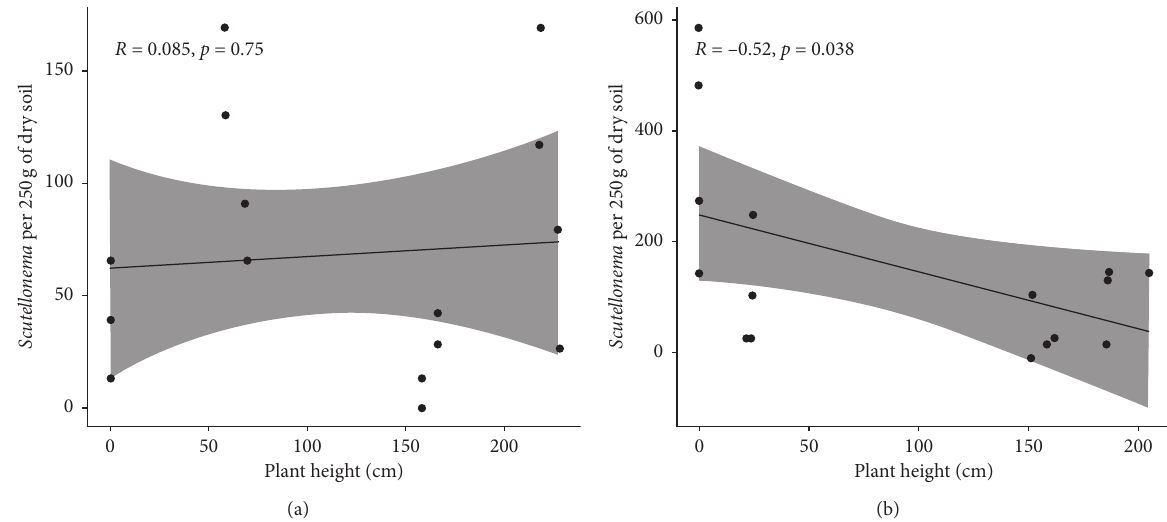
Figure 2: Correlation between plant height and Scutellonema abundance during trial one in 2018 (a) and trial two in 2019 (b) in MPWN treatments. The relationship for 2018 revealed a weak positive association ( R � 0.085, p � 0 . 75), whereas for 2019 it was significantly negative ( R �− 0.52, p � 0 . 038).